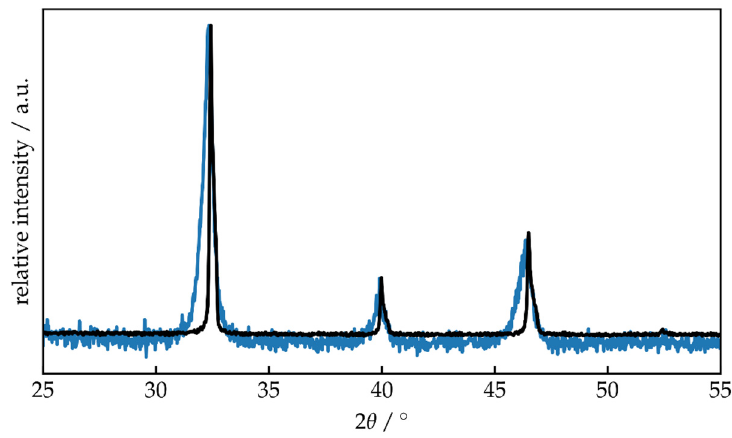
Figure 5. XRD patterns of STF35 powder (black) and an STF35 film (blue).